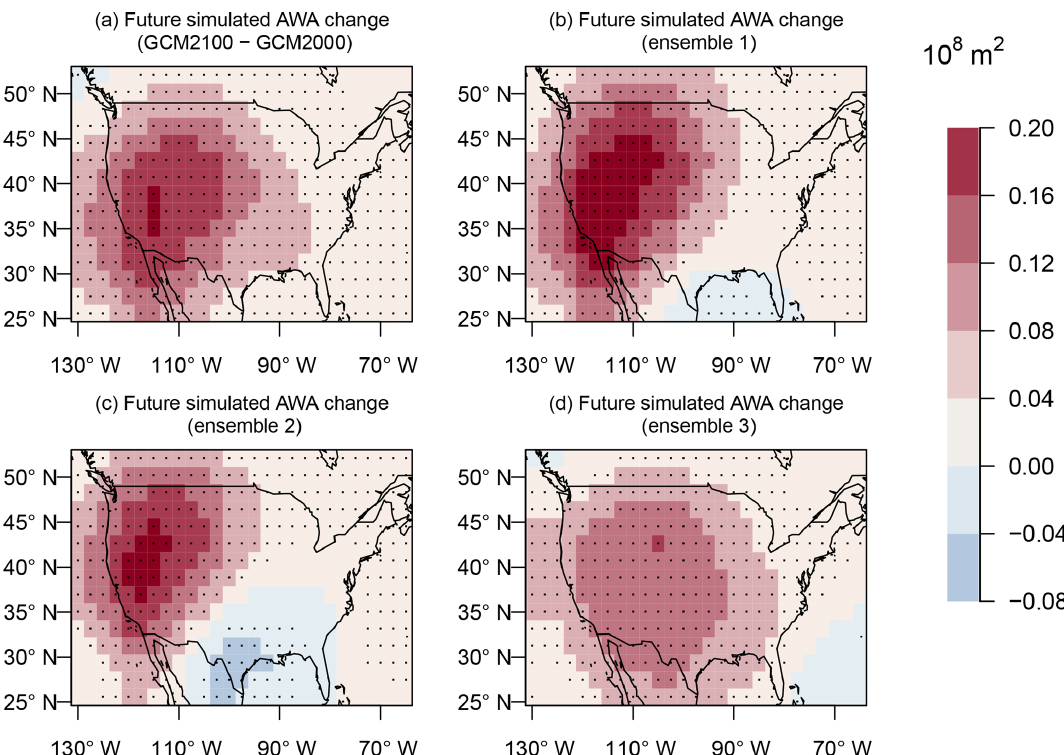
Figure 8. JJA difference in AWA (10 8 m 2 ) between the GCM2100 and the GCM2000 simulation (a) and from the three ensemble members of the REFC2 simulation between 2090 and 2099 and 2000 and 2009 (b–d) . Stippling represents where the change is significant at the 5% level using a Student t